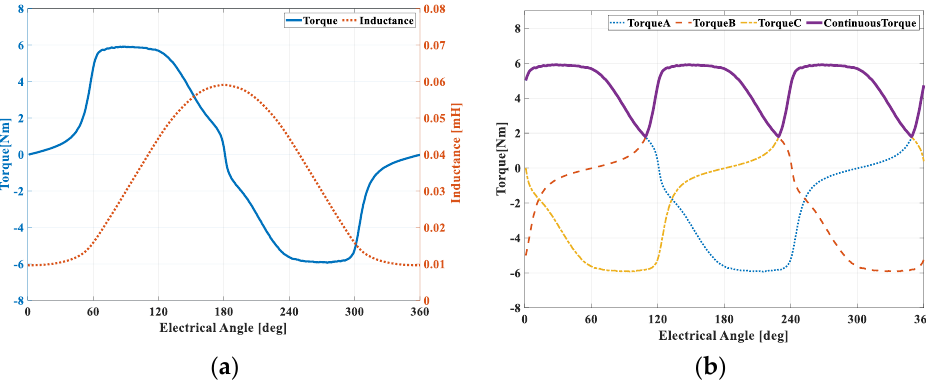
Figure 12. Inductance profile and torque of the final optimized model: ( a ) Static torque and inductance, ( b ) Continuous torque